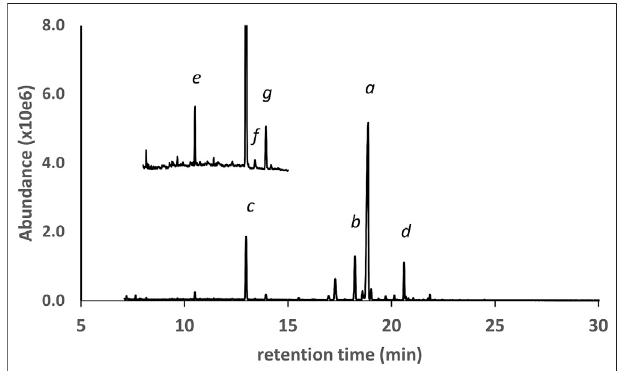
FIGURE5 | GC-MSchromatogram fora cannabis vaping liquid inwhich the predominant cannabinoid was d9THC( a ), and with similar levels of CBD( c ) and d8THC( b ).Minor levels ofother THC isomers wereidenti fi ed ( not labeled ). CBN( d ) and the varinols (expanded scale and offset) were also